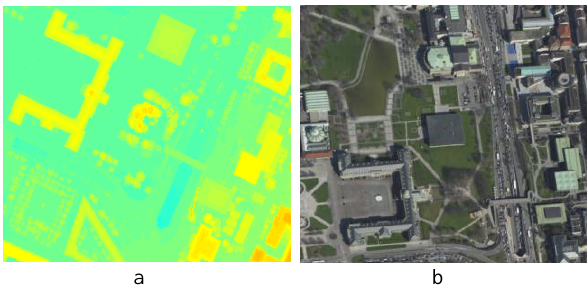
Figure 8. Data set; (a) LiDAR point cloud; (b) Aerial Image; Figure 9 illustrates different steps of proposed method to 3D roof reconstruction of sample building.